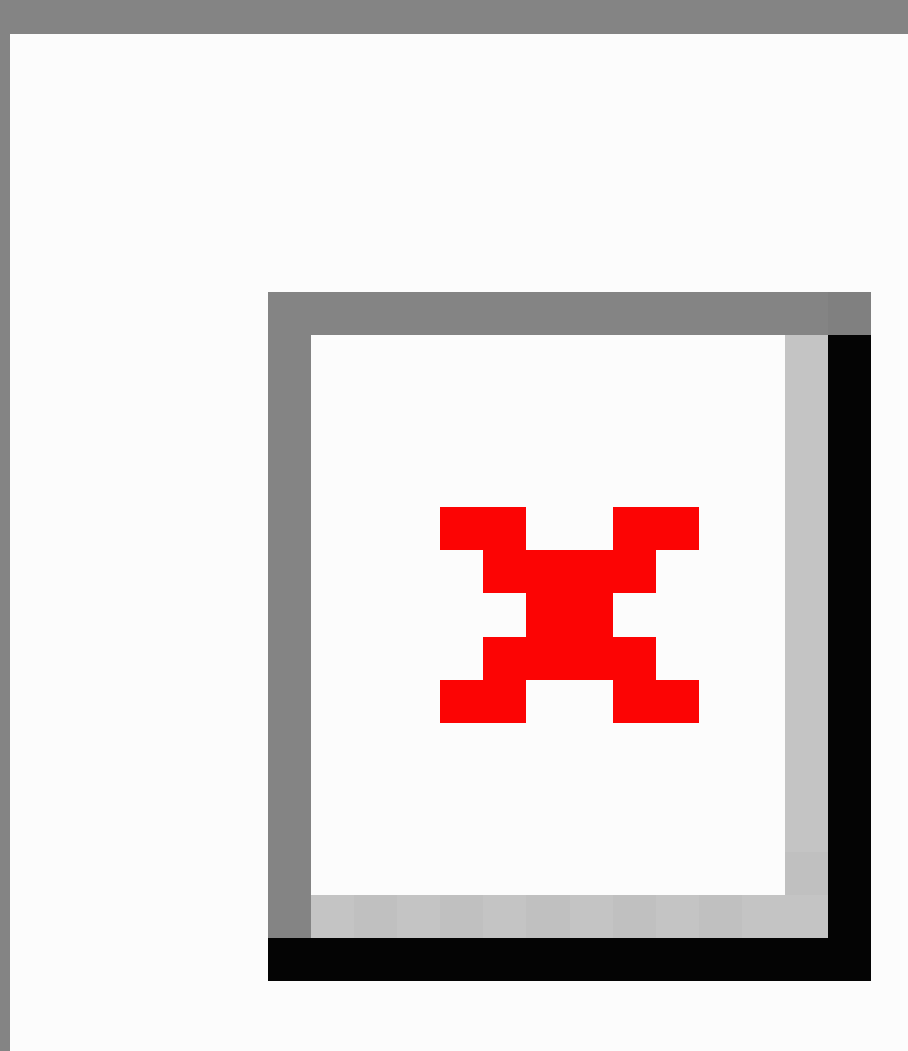
Figure 2. Patient-created proposal for design of the